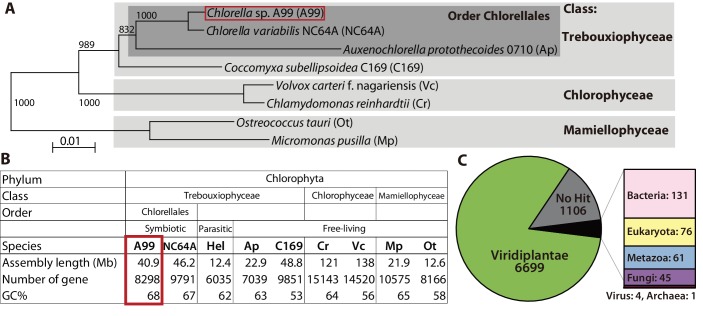
Comparison of key features deduced from the Chlorella A99 genome with other green algae.(A) Phylogenetic tree of eight genome sequenced chlorophyte green algae including Chlorella sp. A99. The NJ tree is based on sequences of the 18S rRNA gene, ITS1, 5.8S rRNA gene, ITS2 and 28S rRNA gene. (B) Genomic features and taxonomy of the sequenced chlorophyte green algae. Hel: Helicosporidium sp. ATCC50920. (C) The proportion of similarity of Chlorella A99 gene models to those of other organisms.